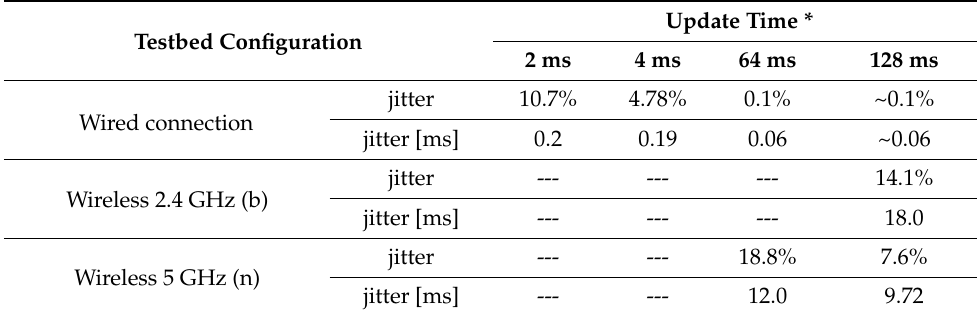
Table 2. Starting configurations of the experimental